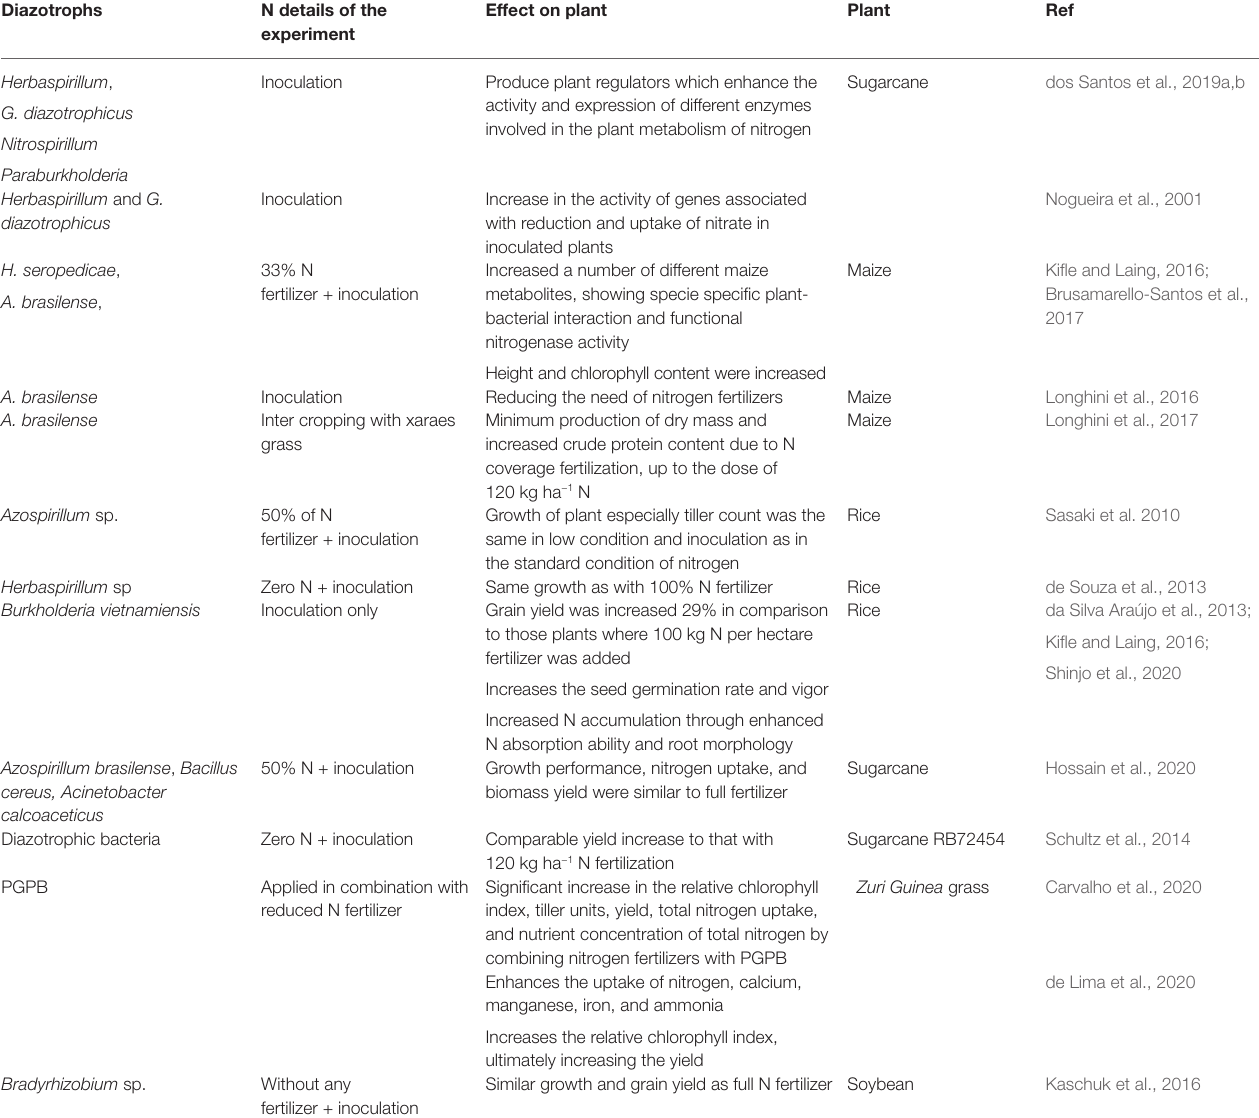
TABLE 3 | List of few diazotrophs’ inoculation under field conditions for BNF under reduced application of N